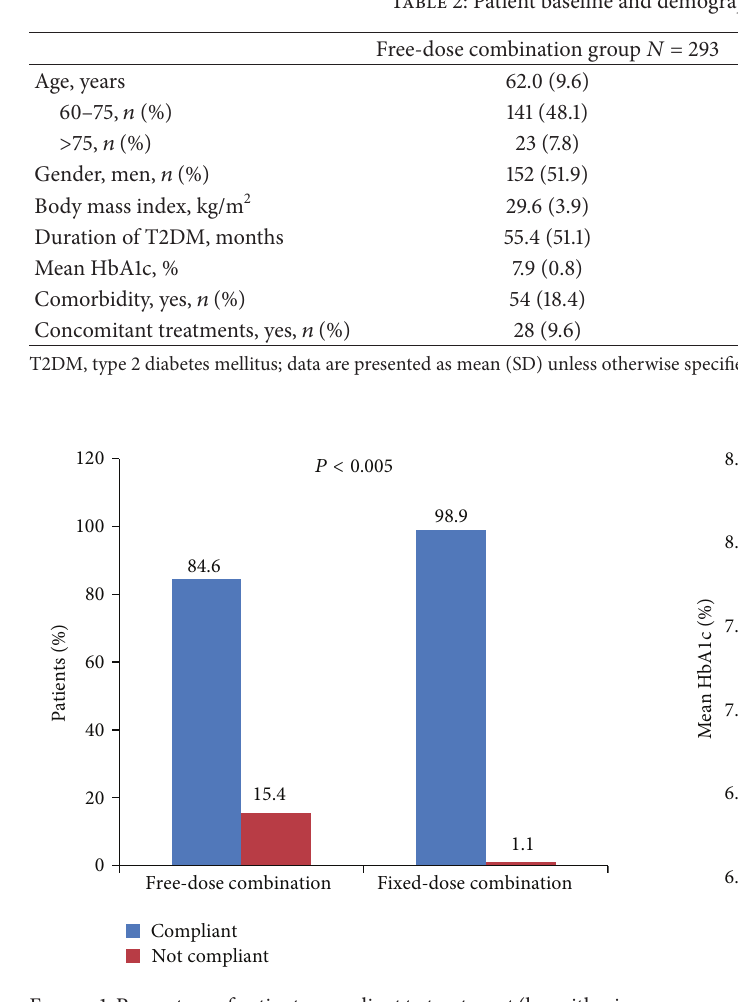
Figure 2: Mean HbA1c (%) at baseline and at end of study (logarith- mic regression model, chi-square